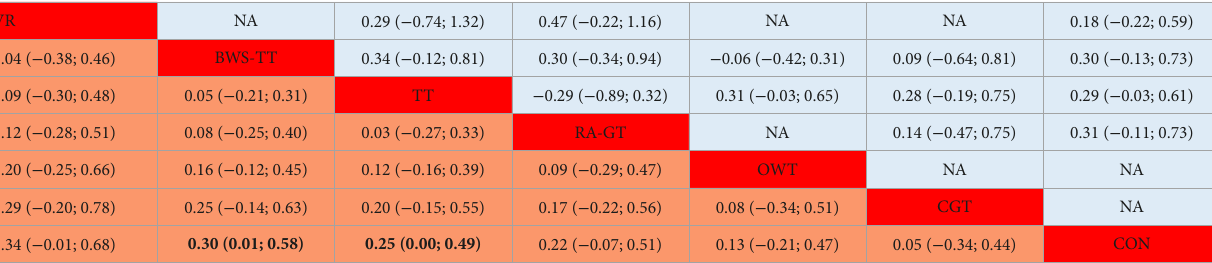
Bold values mean significant difference. Blue means relative degree of direct comparison between gait training. Light red means relative degree of combined comparison between gait training. Deep red means gait training. TT, treadmill; BWS-TT, body-weight-supported treadmill training; RA-GT, robot-assisted gait training; VR, virtual reality gait training; CGT, conventional gait training; OWT, overground walking training; CON, control group.